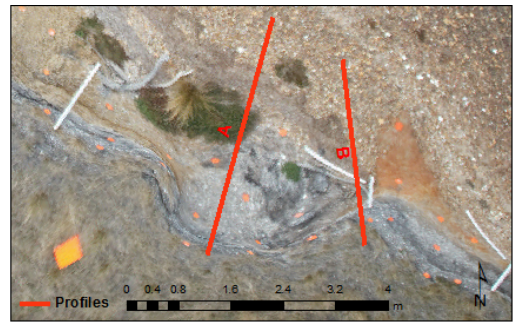
Figure 4: The two profiles within the focus area (see Figure 2). Profile strips 1, 2 and 6 cm wide were extracted from the geo- referenced MVS point clouds and from the Poisson vertex points clouds. The points and derived surfaces were then overlaid and visually compared to evaluate how well the Poisson vertices rep- resent the surface and how well the UAV-MVS point cloud coin- cides with the T-MVS point clouds and derived Poisson vertices and surface